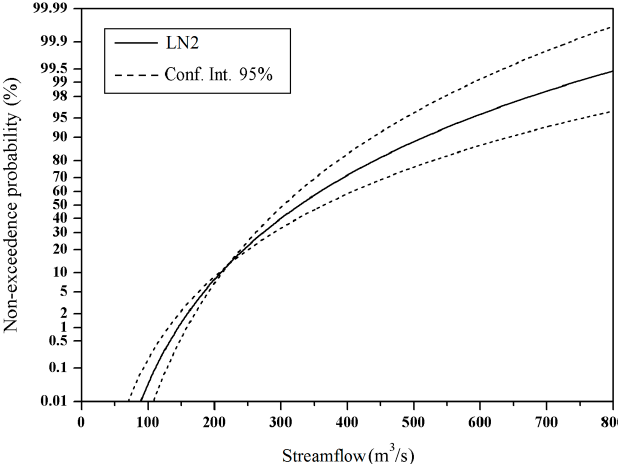
Figure 5. Empirical probability curves and confidence intervals (Conf. Int.) of the LN2 distributions for the observed stream flows at the watershed scale. The scale of y-axis is normal probability. for the observed stream flows at the watershed scale, the scale of y-axis is normal